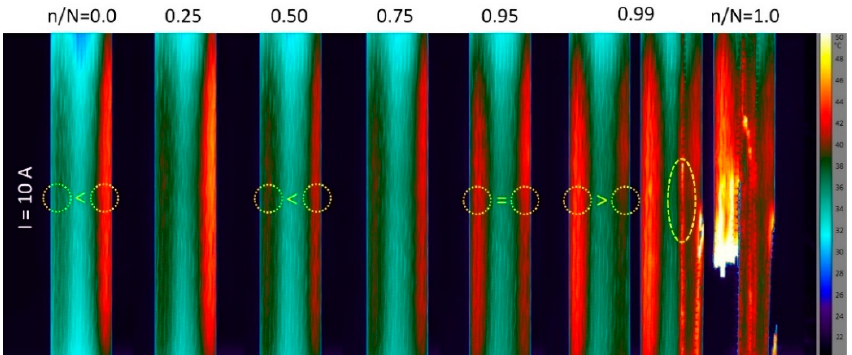
Figure 28. Thermographic image series of a current-carrying specimen (10 A) under a low fatigue load (374 MPa), showing inhomogeneous ohmic heating, high temperature zone shifting and longitudinal splitting.